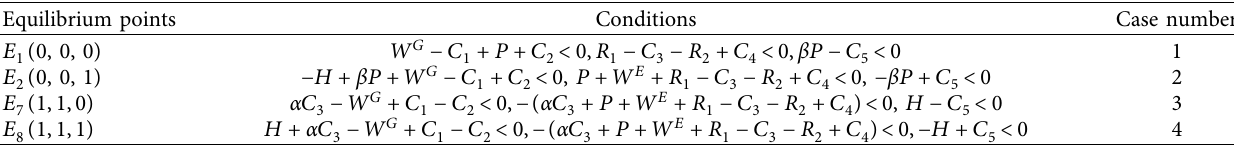
Table 4: The condition of evolutionary stability of equilibrium